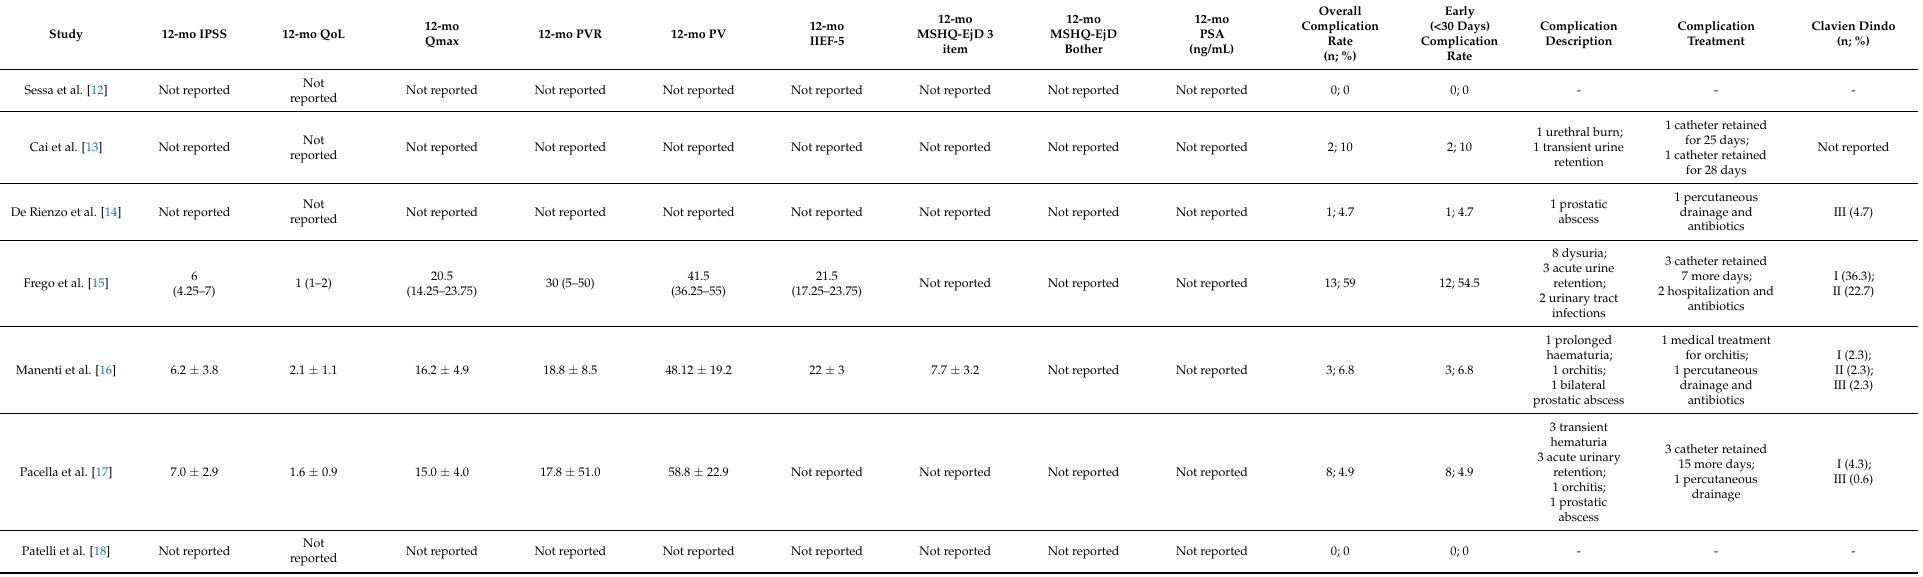
Table 5. Mid-term postoperative surgical and functional outcomes and complications of studies on Trans Perineal Laser Ablation (TPLA) of prostate included in this